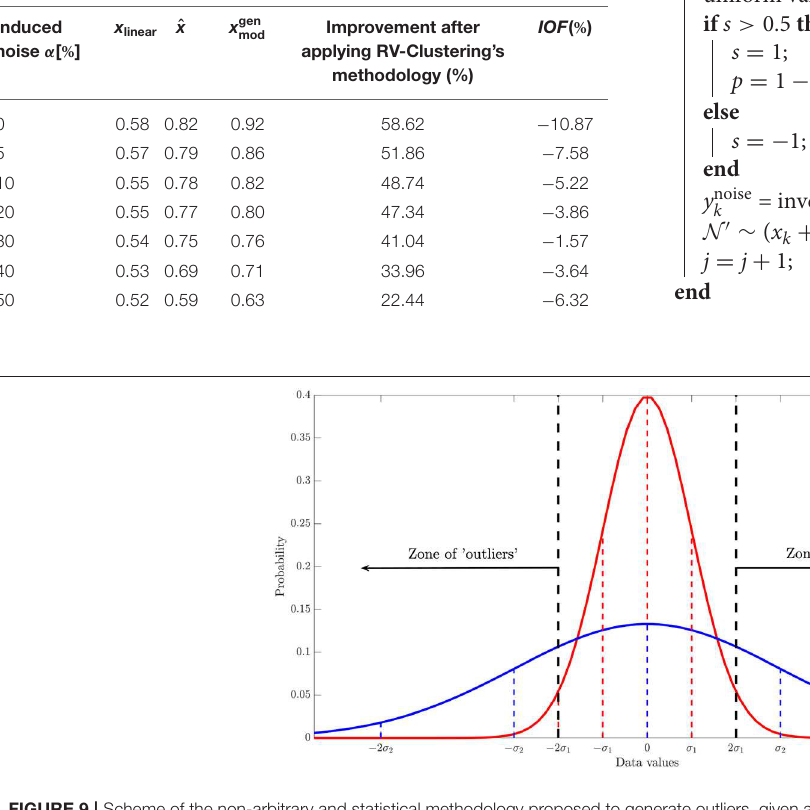
Frontiers in Molecular Biosciences |